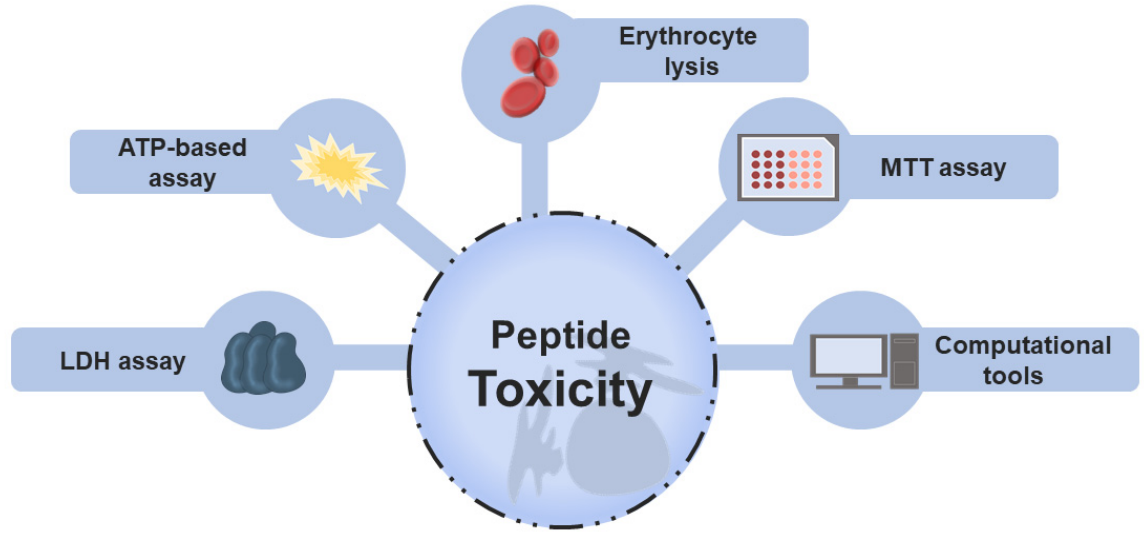
Figure 1. Main approaches employed to evaluate the toxicity of peptides. Traditional screening of non-toxic peptides is performed using different in vitro techniques, including MTT, LDH, erythrocyte lysis, and ATP-based assays. These methods are based on the measurement of intracellular markers released during cell death or lysis, such as hemoglobin (red blood assay), enzymes (LDH assay), or on the analysis of cell viability determined by enzymatic activity, measured, for example, by the MTT assay or by the amount of cell energy (ATP-based assay). Recently, computational models were reported to assist in peptide toxicity prediction.